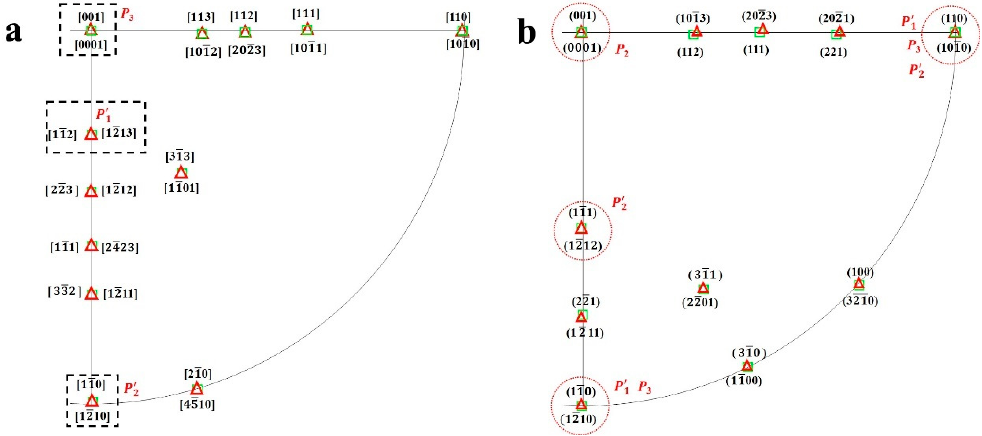
Figure 6. Composite PFs representation of HCP and FCC satisfying the ORs. ( a ) Parallel crystal orientation indexes of two phase, ( b ) parallel plane indexes.